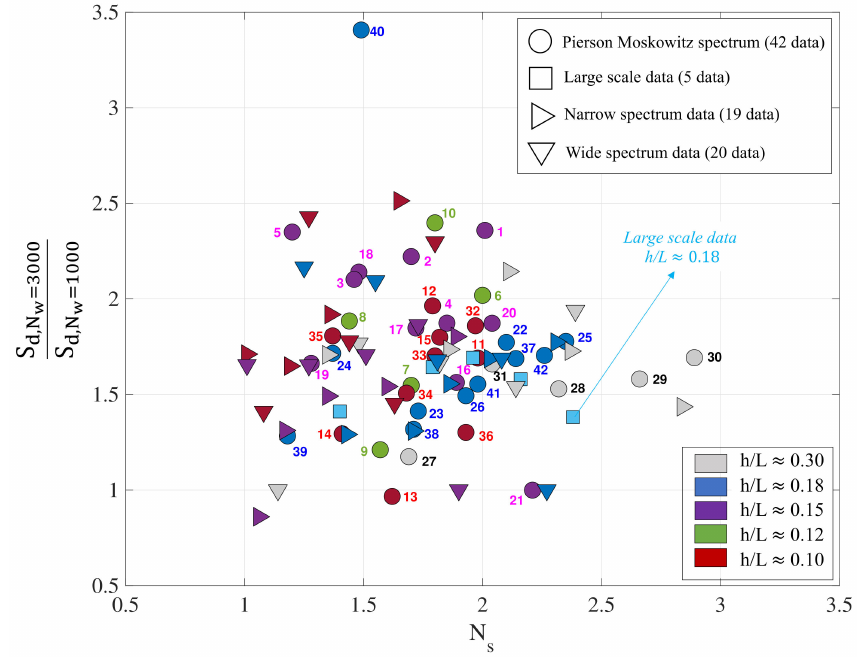
Figure 4. Quotient of the damage progression, S d , under N w = 1000 and N w = 3000 against the stability number, N s , (or wave height, H sI , or wave steepness, H sI / L ). By colors the values of relative water depth, h / L , at the toe of the slope is identified. The data were taken from [28]. Benedicto et al. [33], Clavero et al. [34] and Mendoza et al. [35] showed that